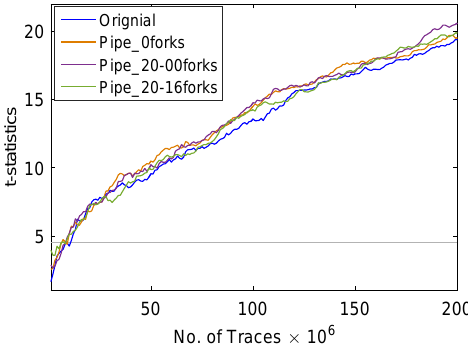
Figure 12: Case study 2: Vdd 1.3 v, shunt 0.0 Ω, 2 shares, iterated_MC 1 , 2 , clock 6 MHz, room temperature, different routings, max ( | t | ) 1st-order, over the number of